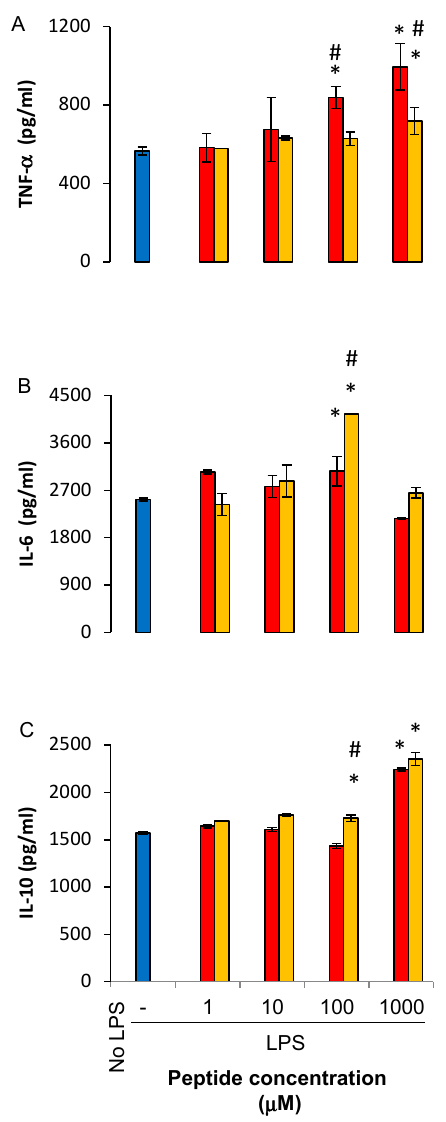
Figure 6. LfP regulate cytokine secretion from murine bone marrow macrophages. Bone marrow macrophages from unchallenged mice were treated with FKE or FKD peptides (1–1000 µ M) for 24 h, followed by LPS exposure for additional 24 h. Next, culture media was collected and its cytokine content was determined by standard ELISA for TNF- α ( A ), IL-6 ( B ), or IL-10 ( C ). Results are representative from two experiments ( n = 4 mice for each experiment) and presented as mean ± SD with biological and analytical duplicates for each treatment. * and # indicate p < 0.05 compared to treatment with LPS alone or with other peptide, respectively. All treatments were statistically different from untreated cells (ANOVA).